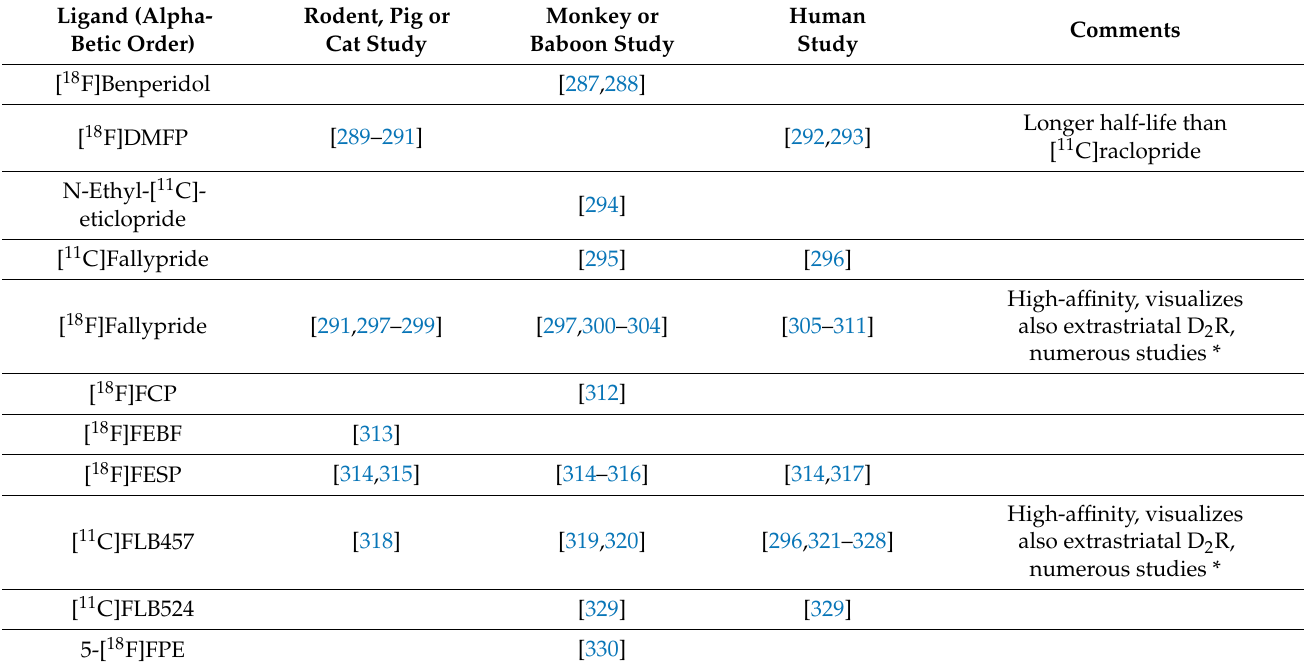
Table 2. Overview of ligands for positron emission tomography (PET) imaging of dopamine D 2/3 receptors. Ligand (Alpha- Betic